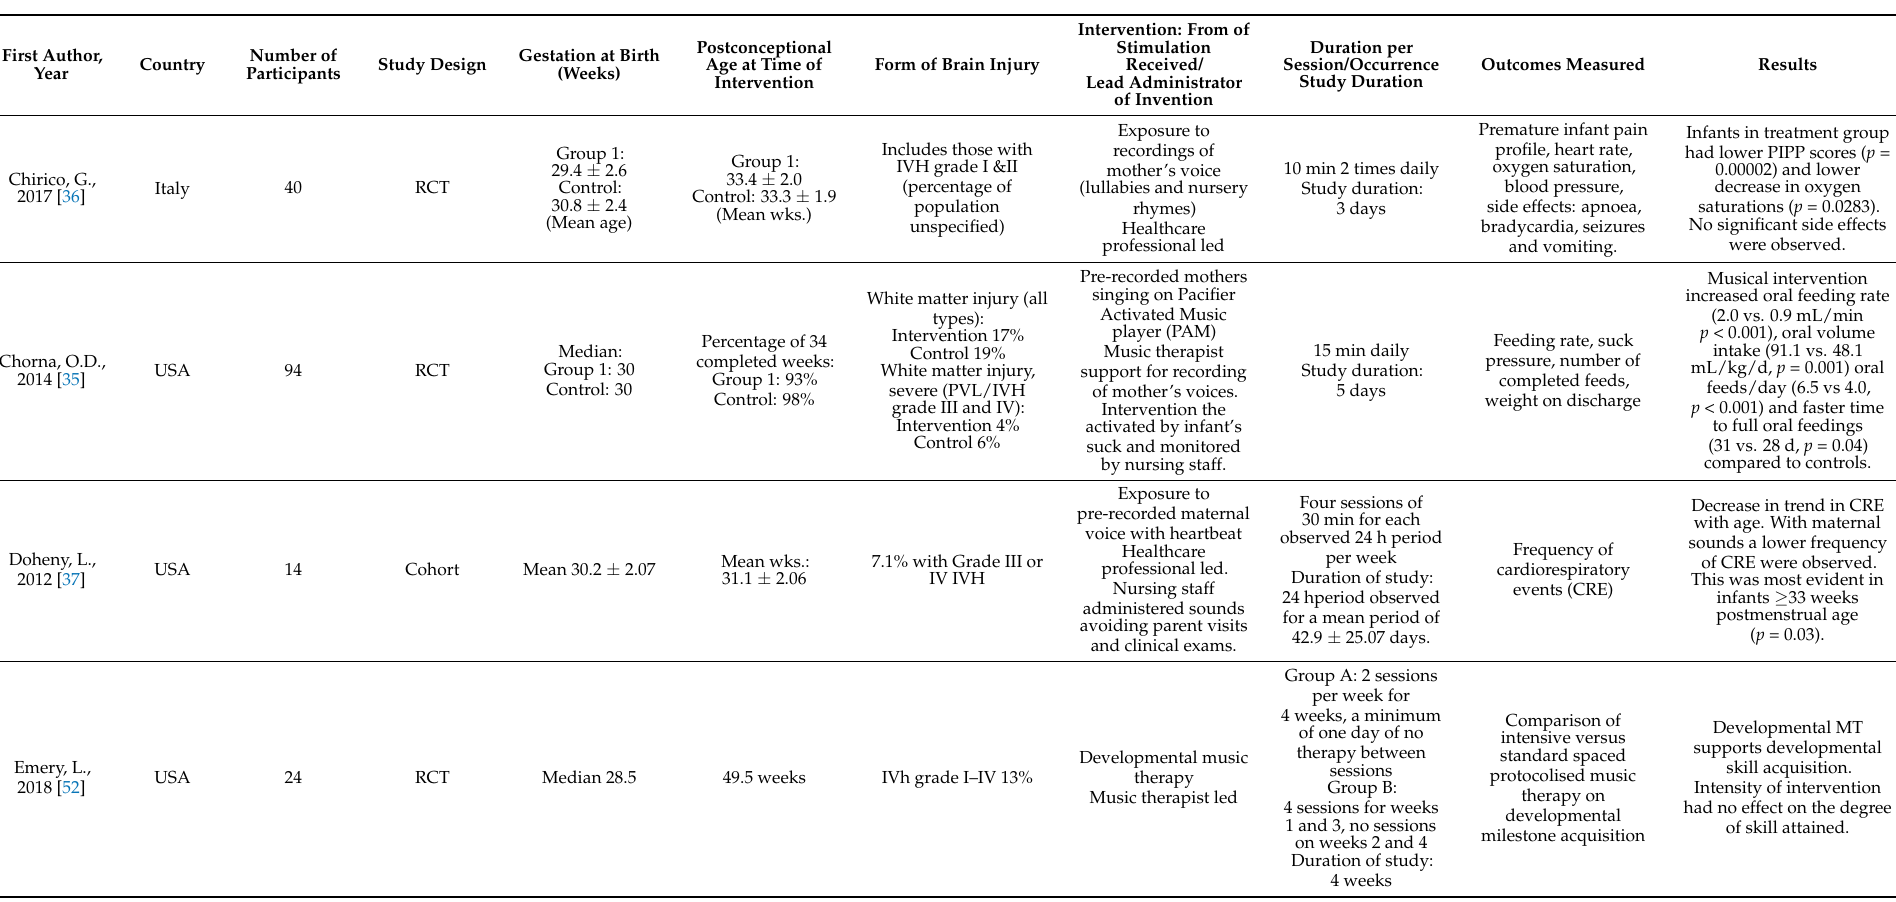
Table 3. Characteristics of included studies (VLBW: very low birth weight; NT: neurotypical; PVL: periventricular leukomalacia; IVH: interventricular haemorrhage; FT: full term; PTM: preterm music; PTC: preterm